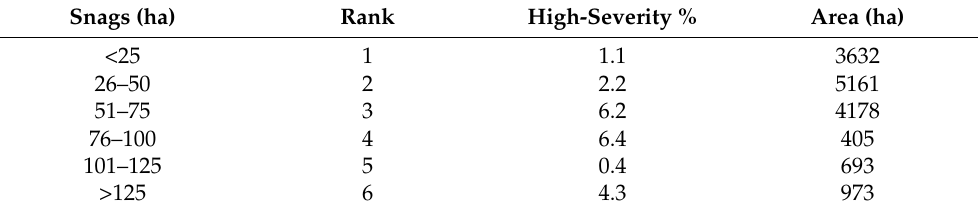
Table 1. Snag density and percent high-severity fire in unmanaged